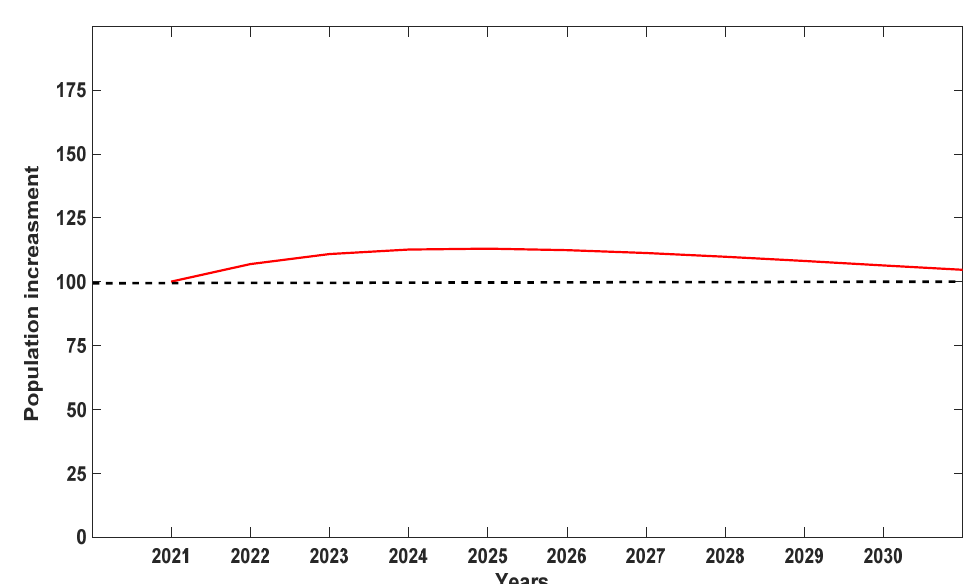
Figure 6. Projection of the behavior of Dendrophylax lindenii for Population A within the Florida Panther National Wildlife Refuge during the next 10 years. Compared to the other six populations, Population A is most stable because seedling recruitment is most evident at this site.